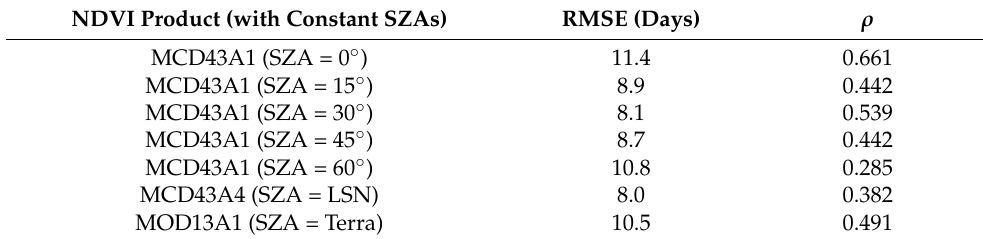
Figure 3. SOS derived from the NDVI time series from 2001 to 2010. SZA = 0°, 15°, 30°, 45° and 60° denote the SOSs derived from the MCD43A1 (BRDF) product with a consistent angle configuration; SZA = LSN and SZA = Terra refer to SOSs derived from the MCD43A4 (NBAR) product and the MOD13A1 (VI) product, respectively. Table 2. Difference between the ground-observed and NDVI-derived SOS.